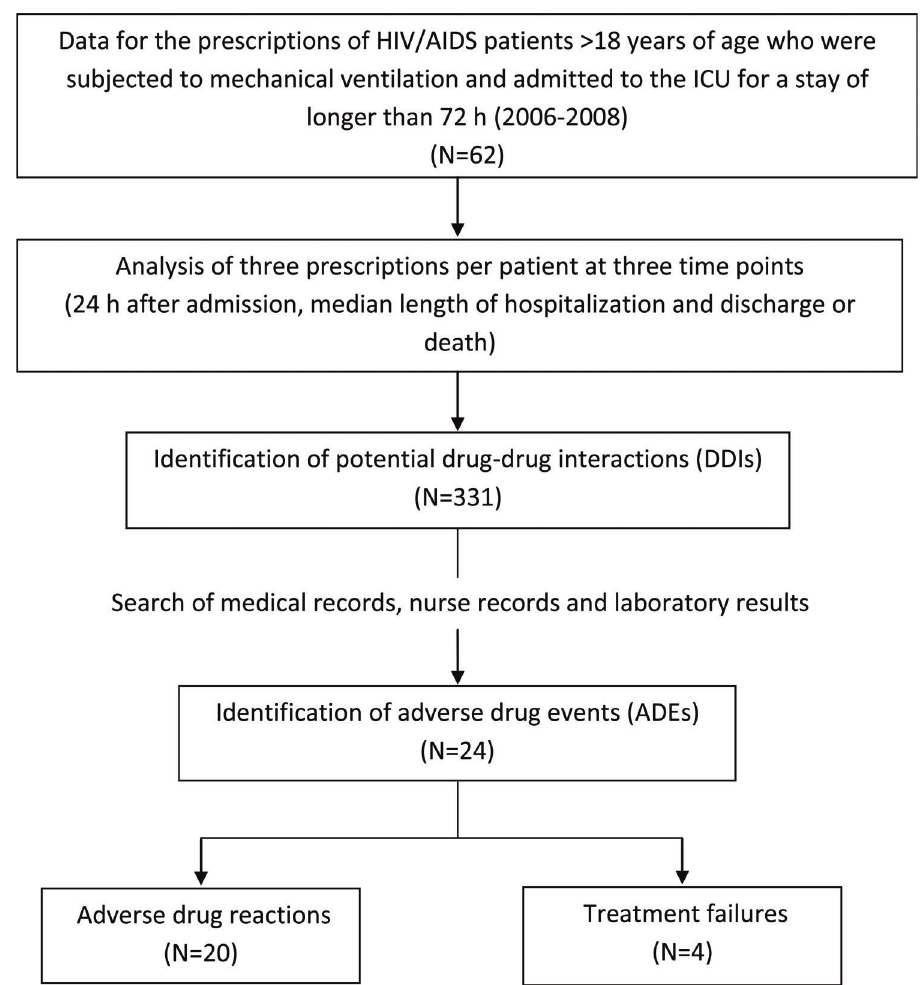
Figure 1 - Flowchart of the